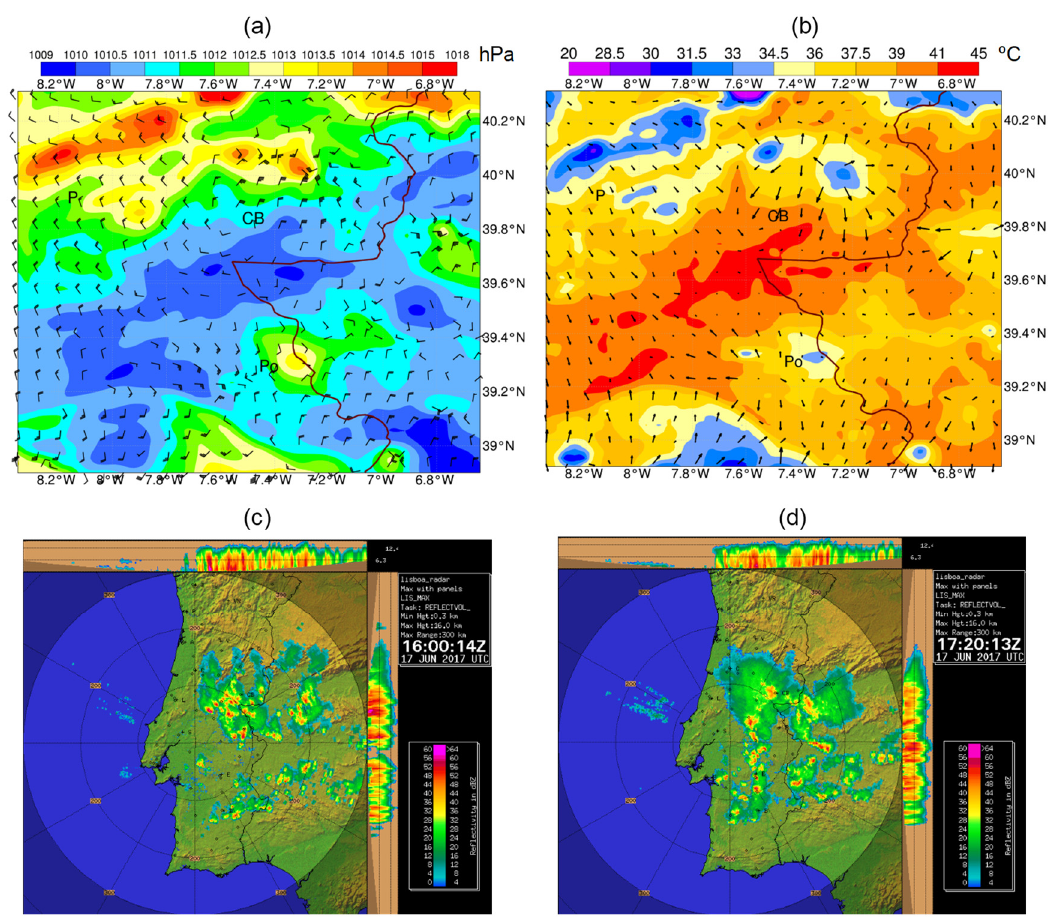
Figure 10. ( a ) AROME forecast of SLP (shading, in hPa) and 10-meter wind gust (wind barbs) valid at 18:00 UTC. Half wind barb corresponds to 5 kt (2.57 m s − 1 ) ( b ) AROME forecast of 2-meter temperature (shading, in °C) and 10-meter wind (wind arrows) valid at 18:00 UTC. The locations of Pedrógão (P), Portalegre (Po) and Castelo Branco (CB) are also shown in the maps. ( c ) Maximum reflectivity (in dBZ) from the IPMA-Coruche Doppler weather radar image at 16:00 UTC (reflectivity in dBZ) on 17 June 2017, ( d ) radar image as in ( c ) but at 17:20 UTC (the exact time of the occurrence of the SHHP event at Castelo Branco).